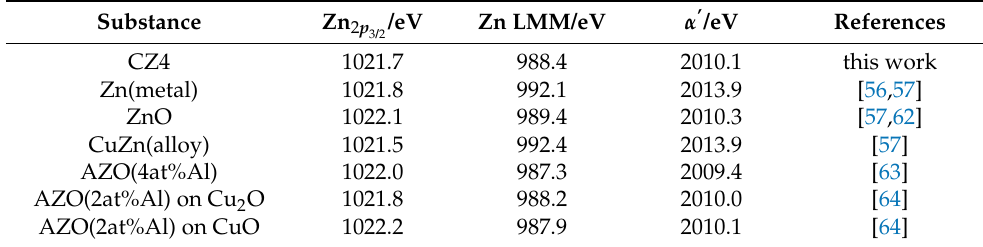
Table 6. Binding energies for the Zn 2 p XPS CL peaks and kinetic energies for the Zn L 3 M 4,5 M 4,5 3/2 Auger peaks, and the modified Auger parameters α (cid:48) for CGO2 and various gallium materials in eV ( ± 0.1 eV). (AZO: Al-doped